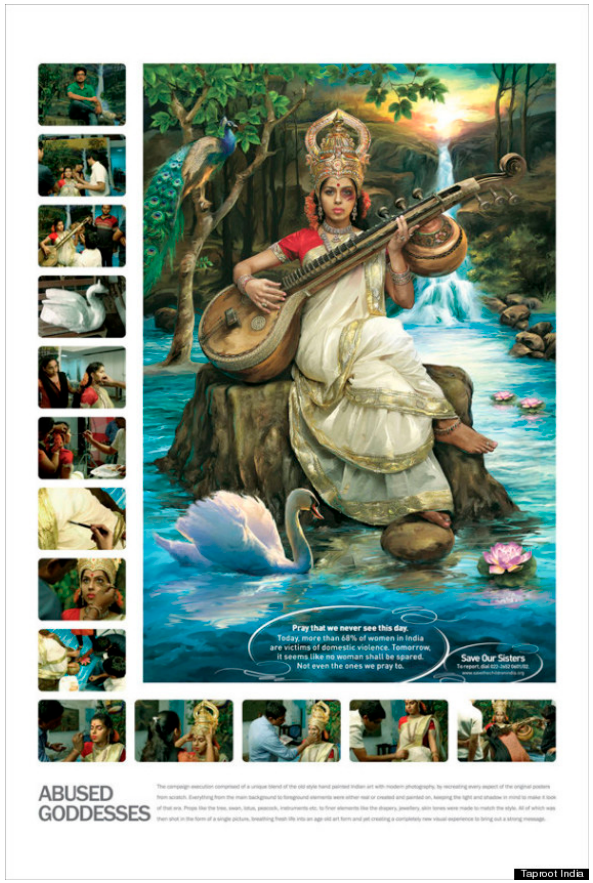
Figure 1. One poster (of three) from the Abused Goddesses campaign depicting the goddess Saraswati. Image Courtesy: Taproot Dentsu.